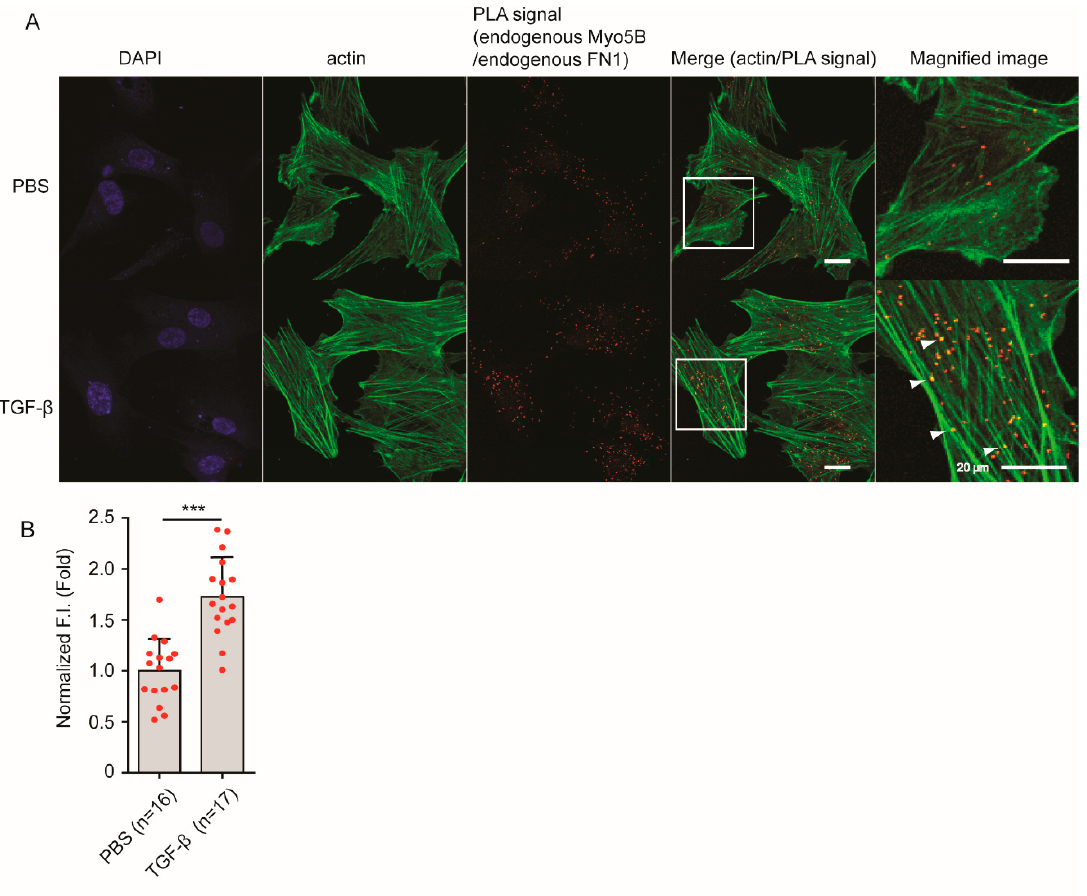
Figure 4. TGF- β stimulation increased close association between Myo5b and FN1 revealed by Proximity-ligation assay. ( A ) TGF- β stimulation increased proximity-ligation (PLA) signal between Myo5b and FN1. Scale bars, 20 μ m. Magnified images of the boxed areas are shown in the right panels. Proximity ligation signals are found on actin filaments (arrowheads). Scale bars, 20 μ m. ( B ) Quantitative analysis of intensity of the signals (mean ± SD), *** p < 0.001. Proximity-ligation assay revealed close association of Myo5b and FN1 that is induced by TGF- β stimulation. The red spots in bar graph displays the distribution of data points.